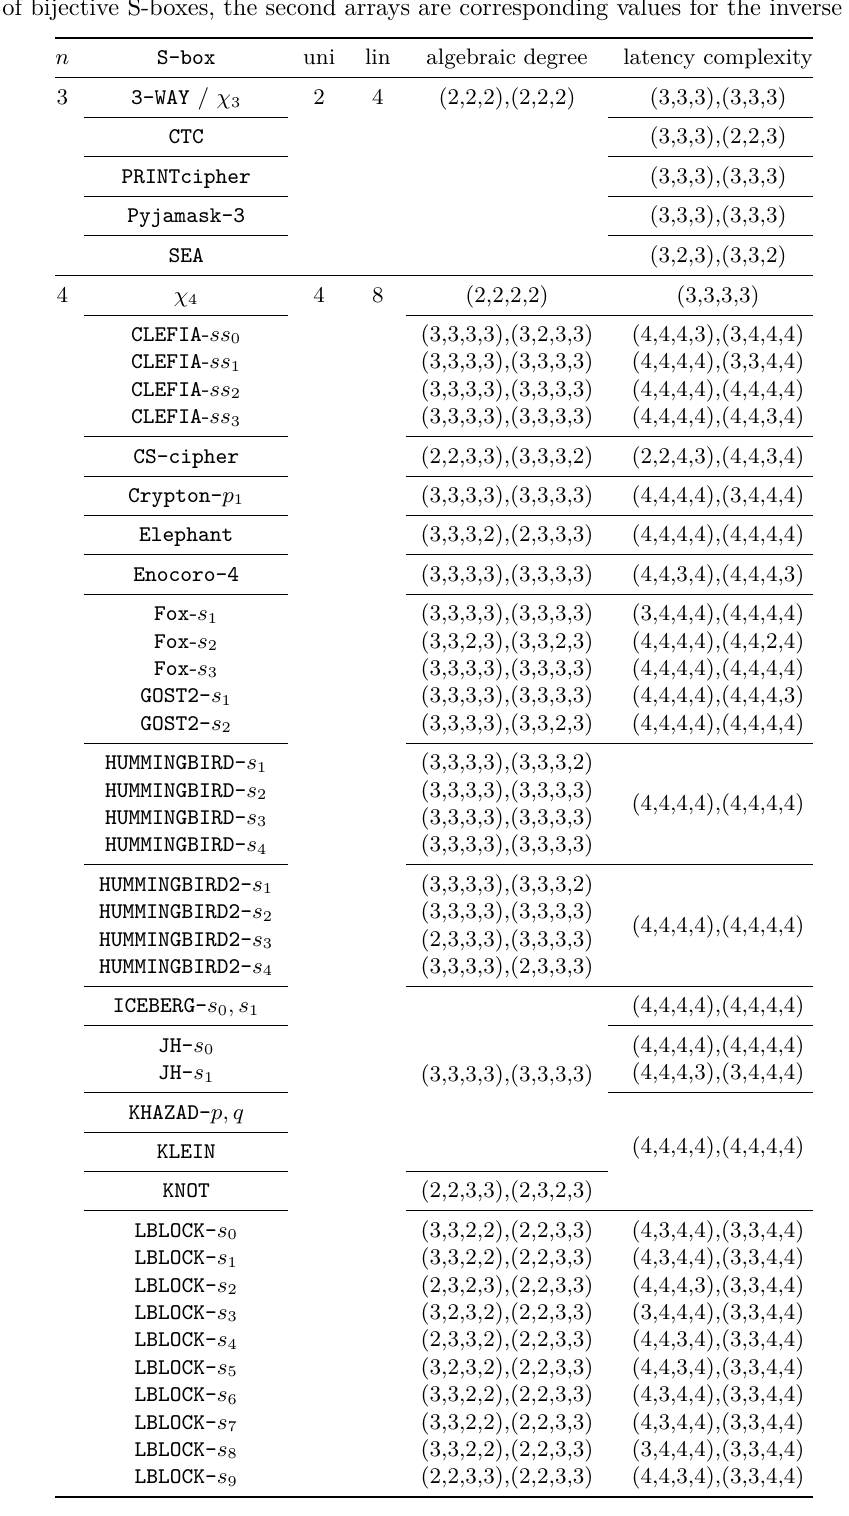
Table 7: Latency complexity of known S-boxes together with their uniformity, linearity and algebraic degree. In the columns for algebraic degree and latency complexity, in the case of bijective S-boxes, the second arrays are corresponding values for the inverse